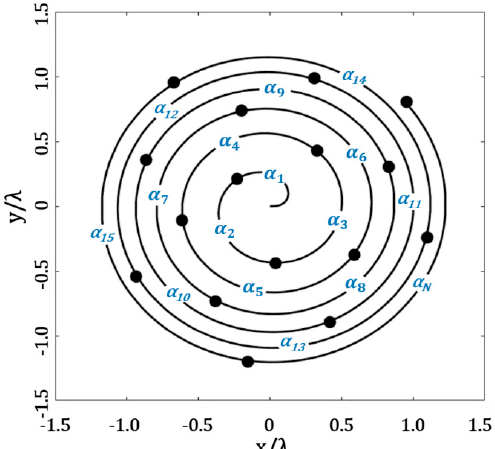
Figure 4. Application of GA to optimize the angular separations of the Fermat spiral array.